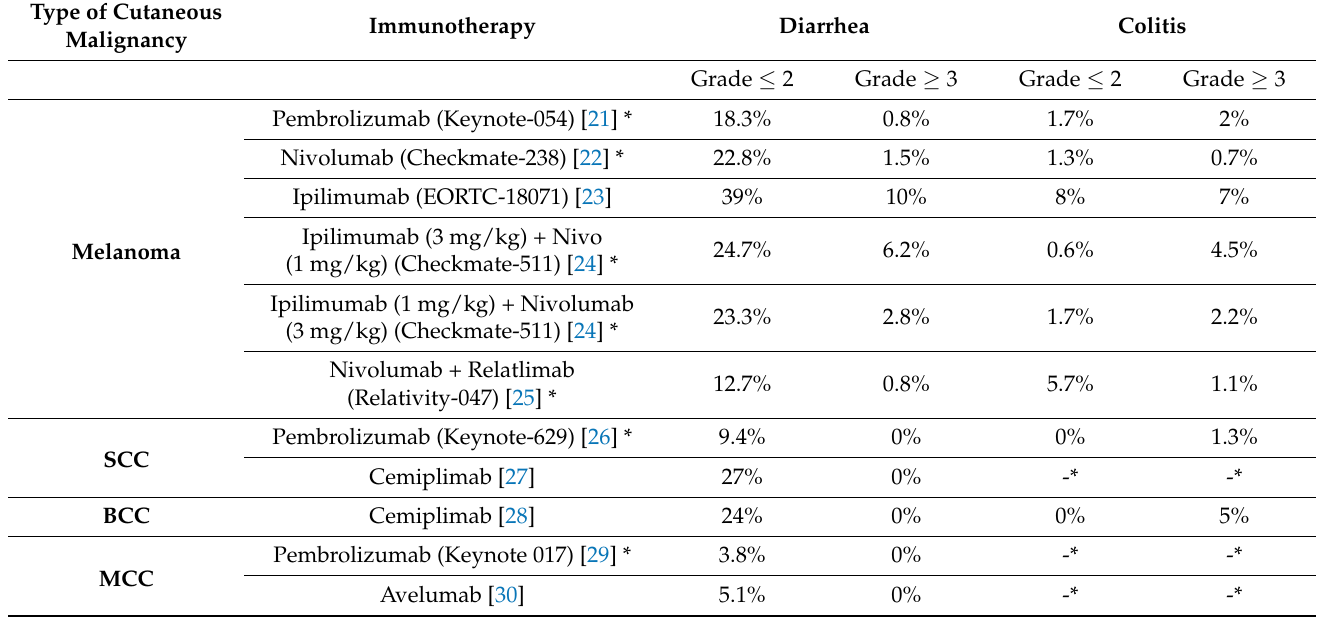
Table 2. Commonly used checkpoint antibodies in cutaneous malignancies with incidence of diarrhea and